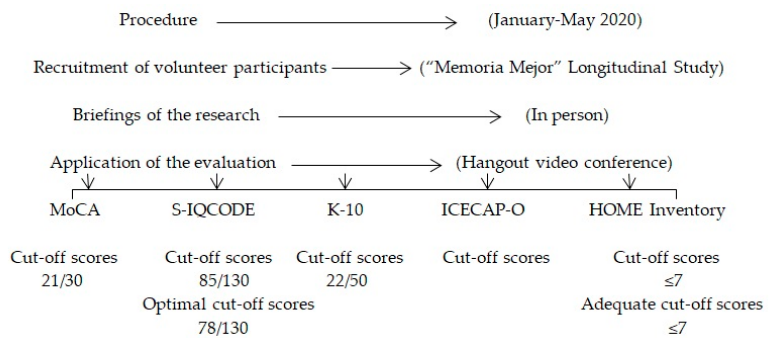
Figure 1. Flow diagram that describes the research procedure.